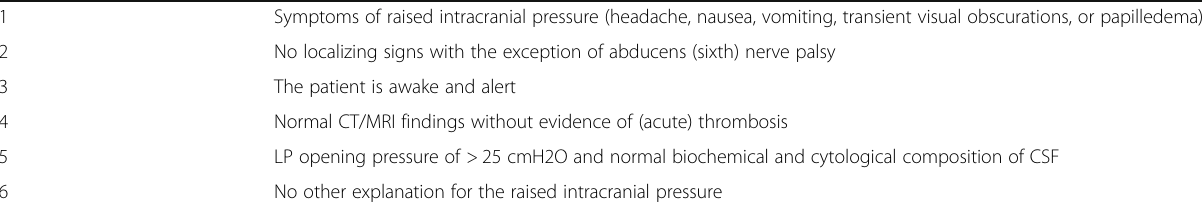
Table 1 Modified Dandy criteria according to [9,